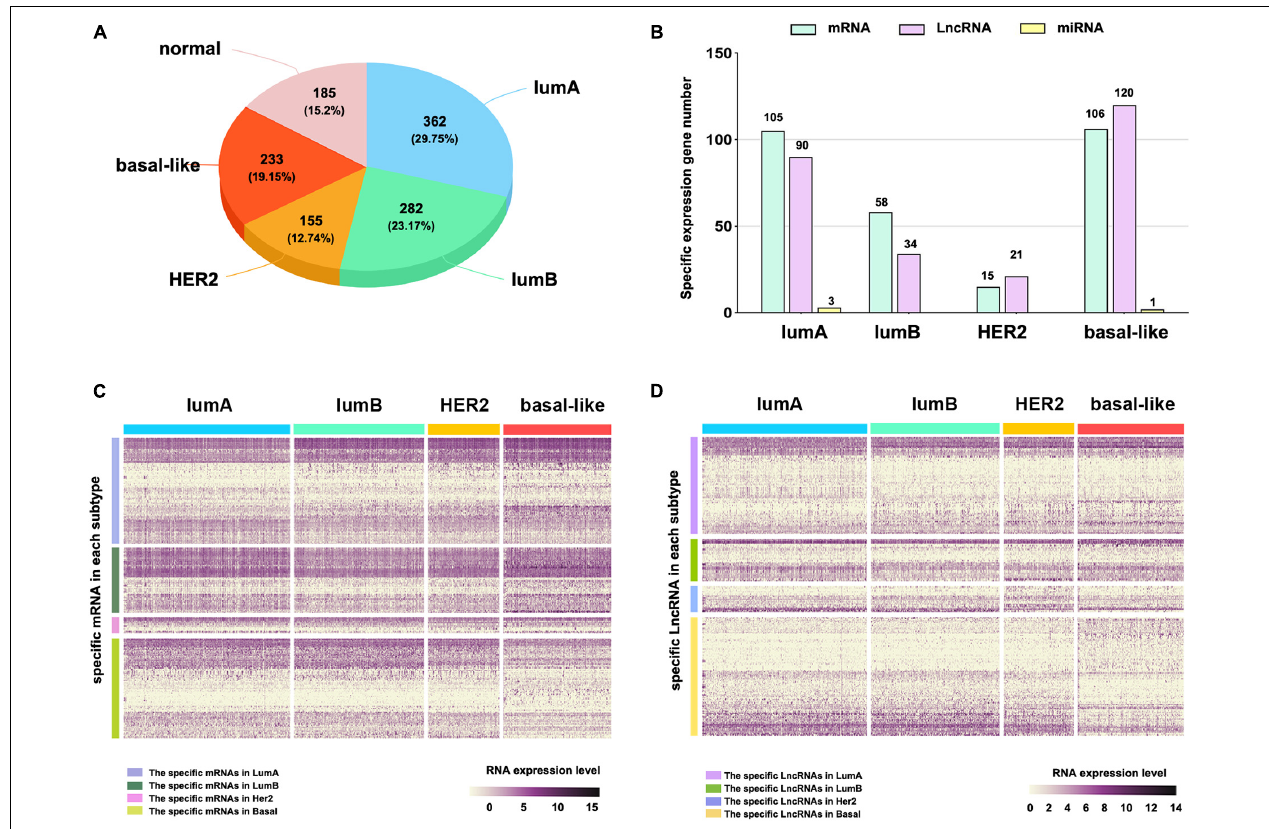
FIGURE 1 | The subtype-specific RNA expression. (A) The number of samples of each breast cancer subtype. (B) The number of subtype-specific RNAs in each subtype. (C) The expression of specific mRNAs in each subtype. (D) The expression of specific lncRNAs in each